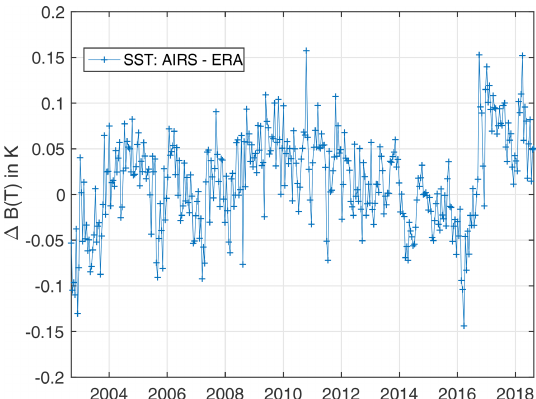
Figure 15. Zoom of Fig. 14 that highlights the shift in the AIRS – ERA-I SST anomaly presumably due to the AIRS 25 Septem- ber 2016 cooler restart. A small shift is also seen at the date of the November 2003 Aqua shutdown.